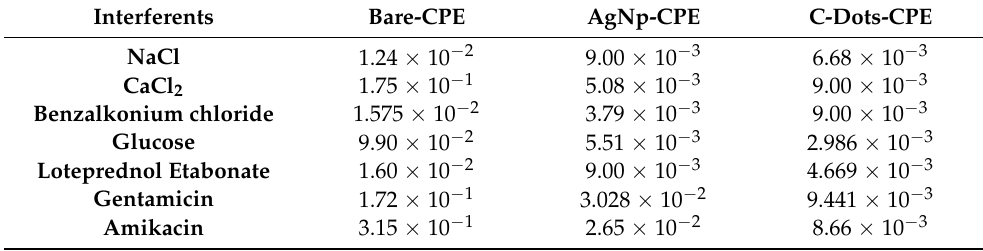
Table 3. Selectivity coefficients (K pot method